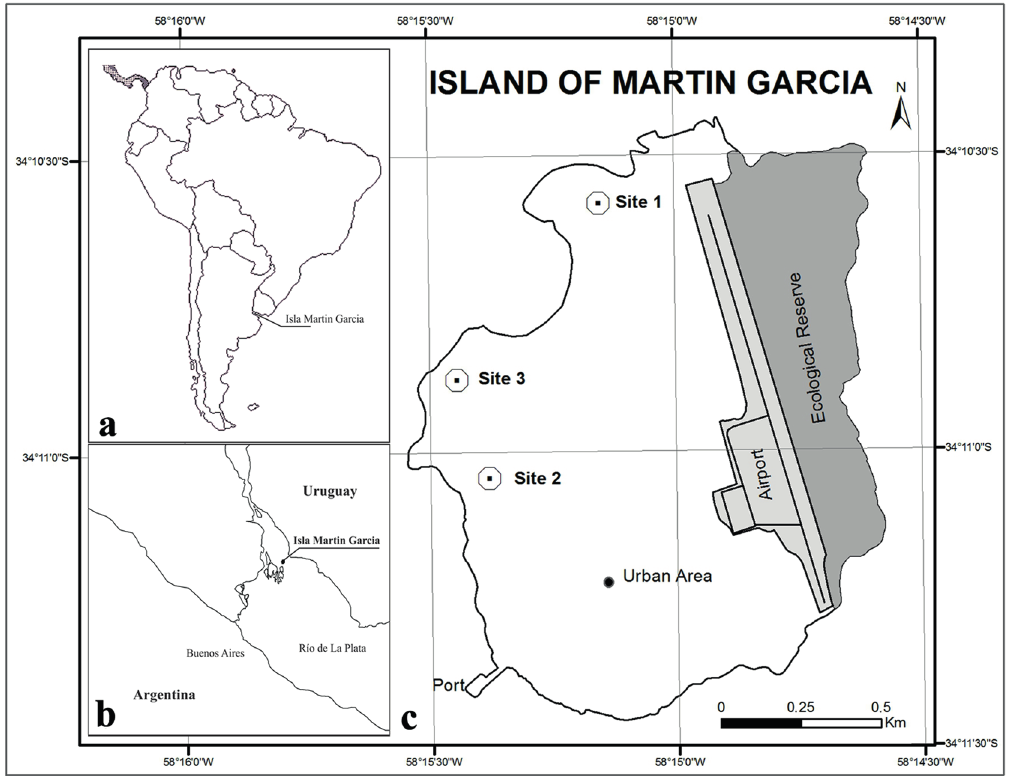
Figure 1 - Location of the Natural Reserve Island of Martín García (Argentina) in ( a ) South America; ( b ) the estuary of Rio de La Plata River. ( c ) Map of the Island showing study sites 1, 2 and